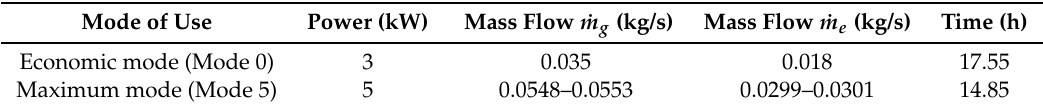
Table 4. Comparison of the economic mode and the maximum mode for a radiation of 900 kW/m 2